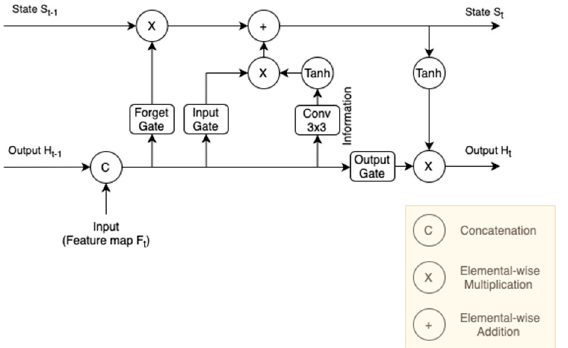
Figure 6. Temporal Conv LSTM architecture. State S t-1 and Output H t-1 are retrieved from the memory. Forget Gate, Input Gate and Output Gate operate the 3 × 3 convolutions followed by the activation function.